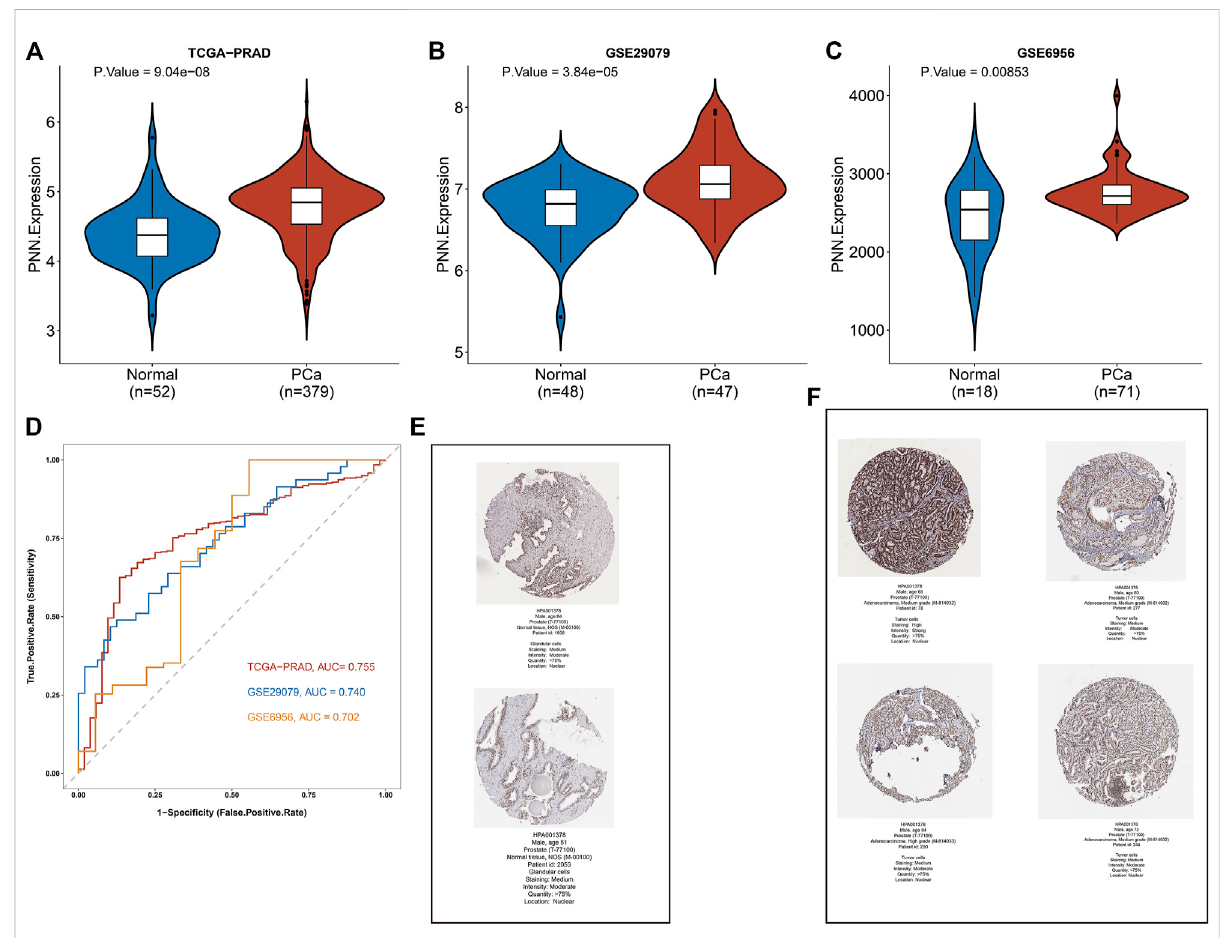
FIGURE 2 PNN expression pro fi le and its diagnostic value in Prostate Cancer (PCa). (A – C) Comparison of PNN expression levels in the TCGA-PRAD, GSE29079, and GSE6956 datasets. (D) The diagnostic value of PNN as evaluated by ROC curve. (E,F) Immunohistochemistry results of normal (two cases) and PCa tissue (four cases) from the HPA